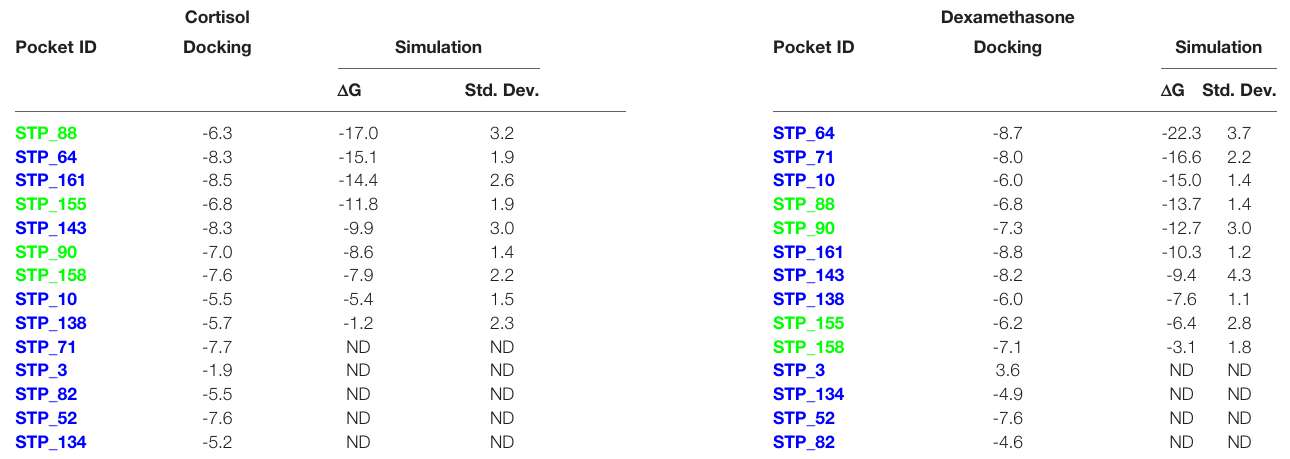
TABLE 2 | Binding energies of cortisol and dexamethasone for each S1 pocket of chain B after docking and MD. Cortisol Dexamethasone Pocket ID Docking Simulation Pocket ID Docking D G Std.